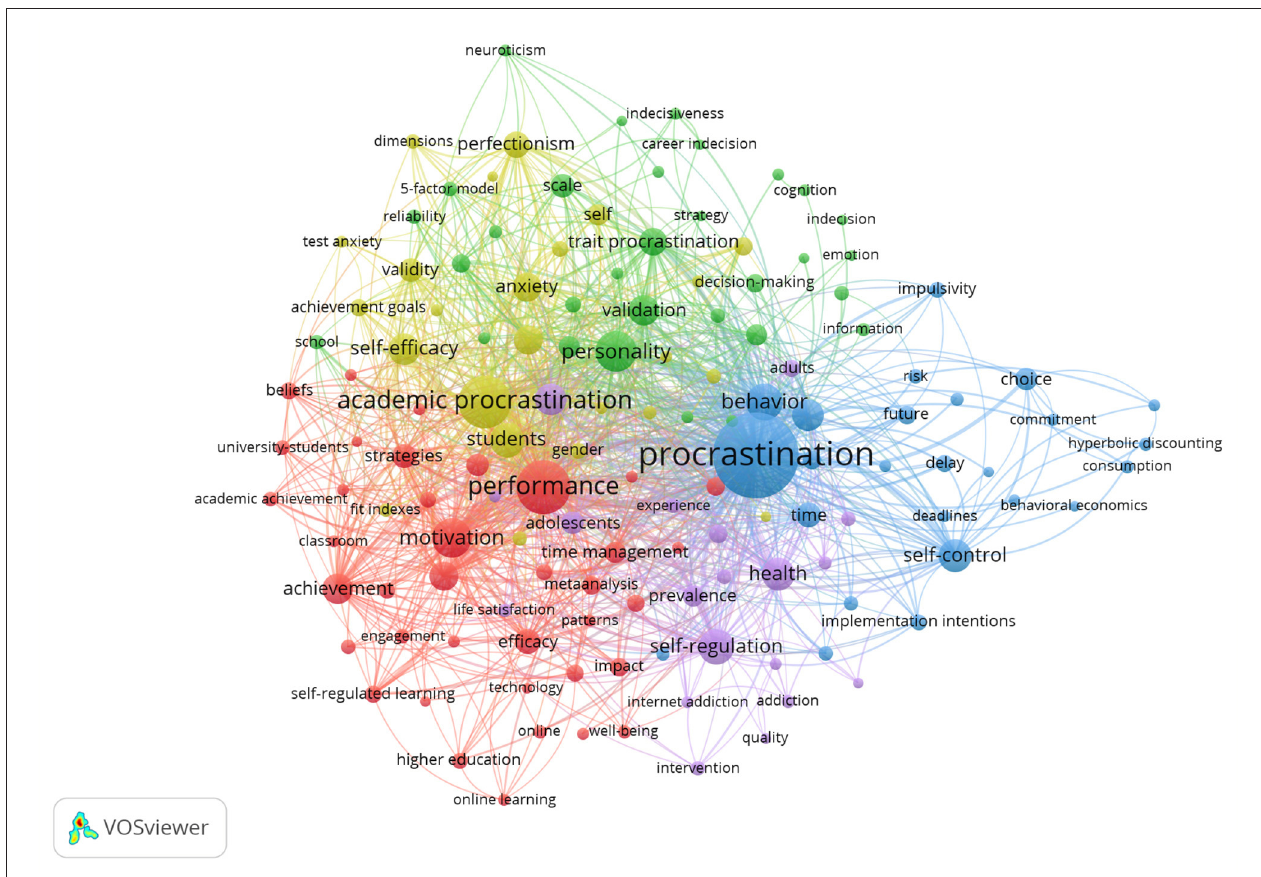
FIGURE 3 | Keywords co-occurrence network for procrastination research.